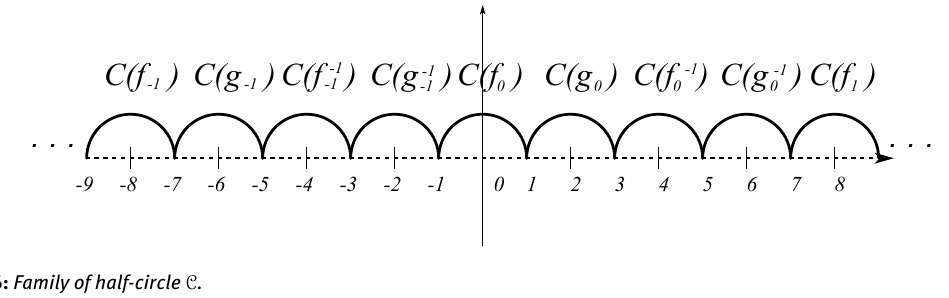
Figure 6: Family of half-circle C .